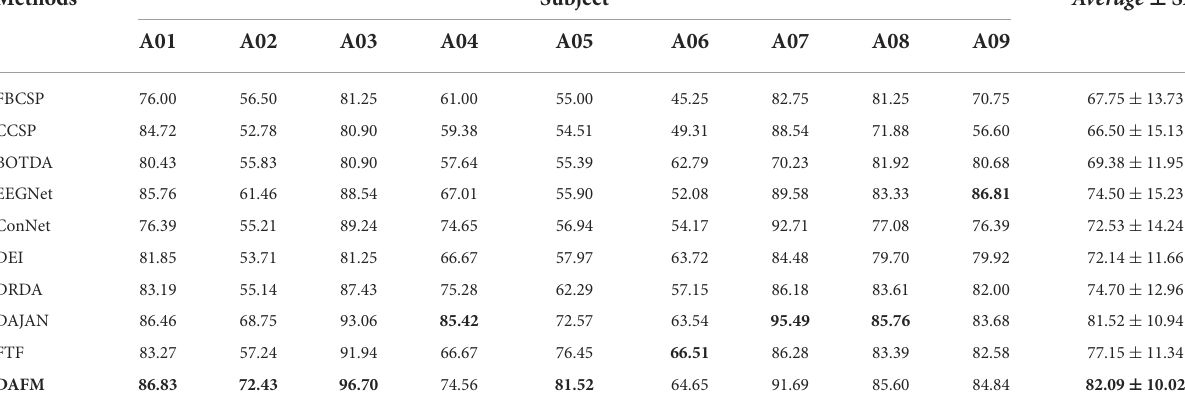
TABLE 3 Classification accuracies ( % ) obtained with the dataset BCI competition IV-2a.